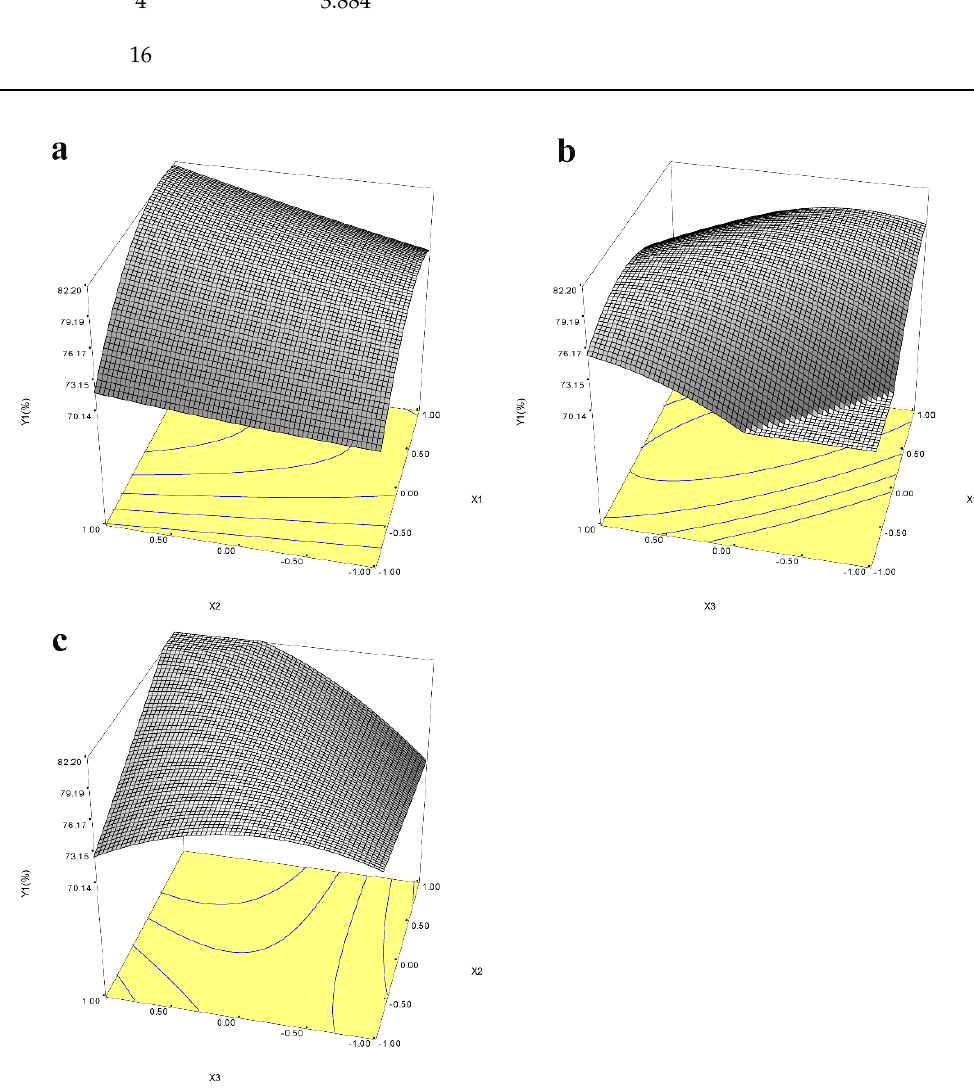
Figure 6. Response surface maps of the interaction of enzyme activity ( X 1 ) and pH ( X 2 ) ( a ), enzyme activity ( X 1 ) and hydrolysis time ( X 3 ) ( b ), and pH ( X 2 ) and hydrolysis time ( X 3 ) ( c ) on icariin yield ( Y 1 ). The coordinate X represents the code value, not the actual value. Table 3. ANOVA of the quadratic model for the yield of icariin.